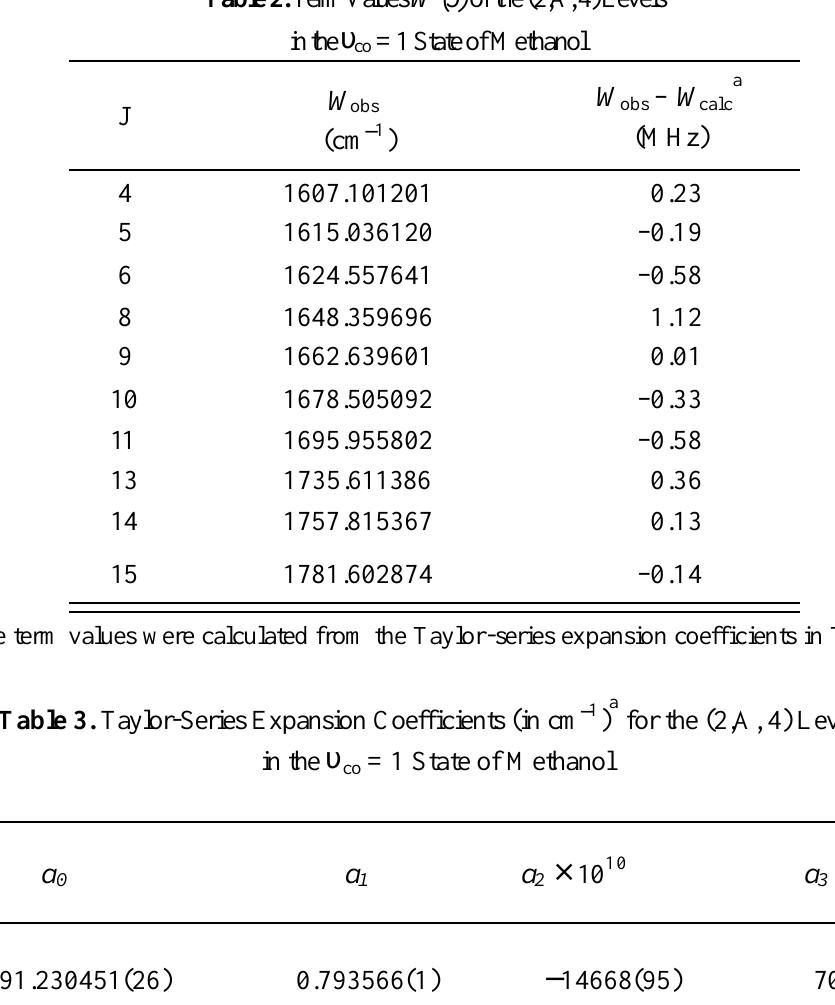
Table 2. Term Values W (J) of the (2,A, 4) Levels